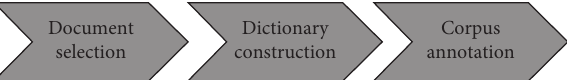
Figure 1, from the selection of corpus documents and text